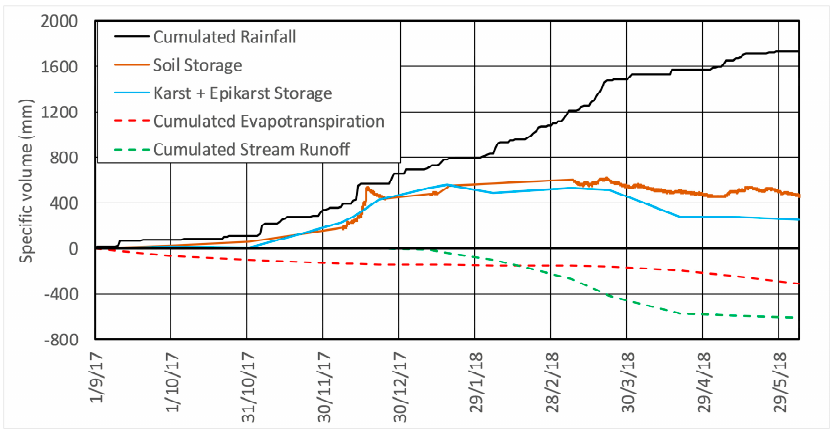
Figure 4. Specific water balance of the slope, estimated from field monitoring data between 1 September 2017 and 6 June 2018.